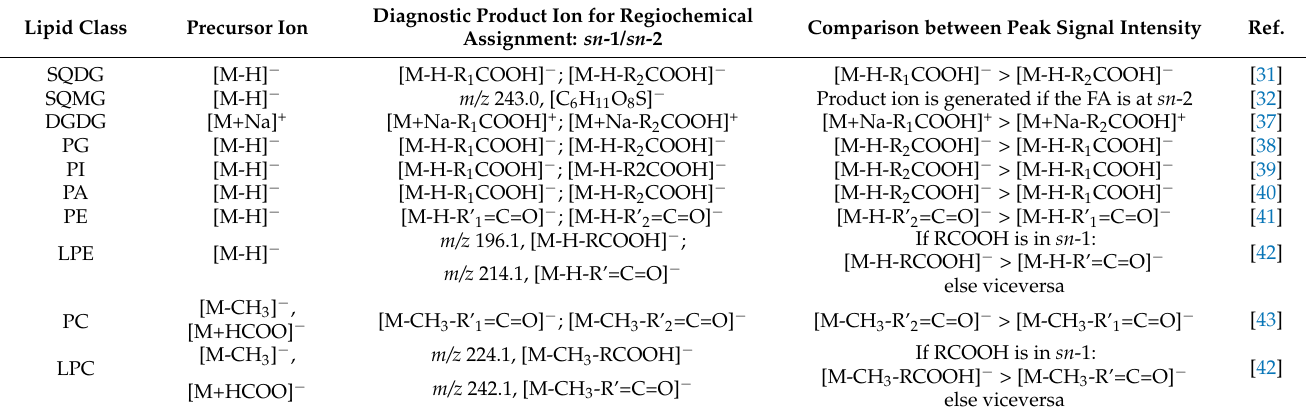
Table 2. Summary of class-related regiochemical assignment by ESI-MS/MS of phospholipids, sulfolipids, and glycolipids along with their lyso forms identified in the lipid extract of wakame brown alga ( U. pinnatifida ). Lipid